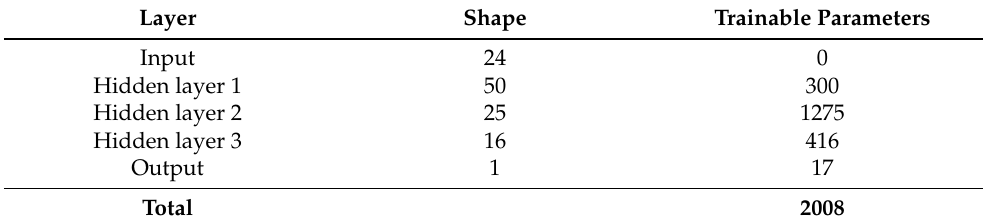
Table 3. The number of trainable parameters of the proposed OFDF model with PCA. Layer Shape Trainable